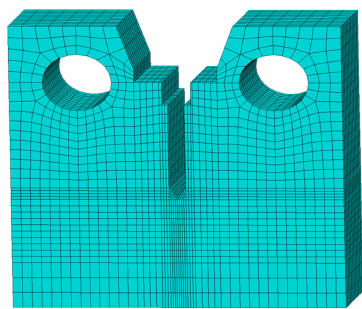
Figure 12. The meshing model of the extended finite element method(XFEM).